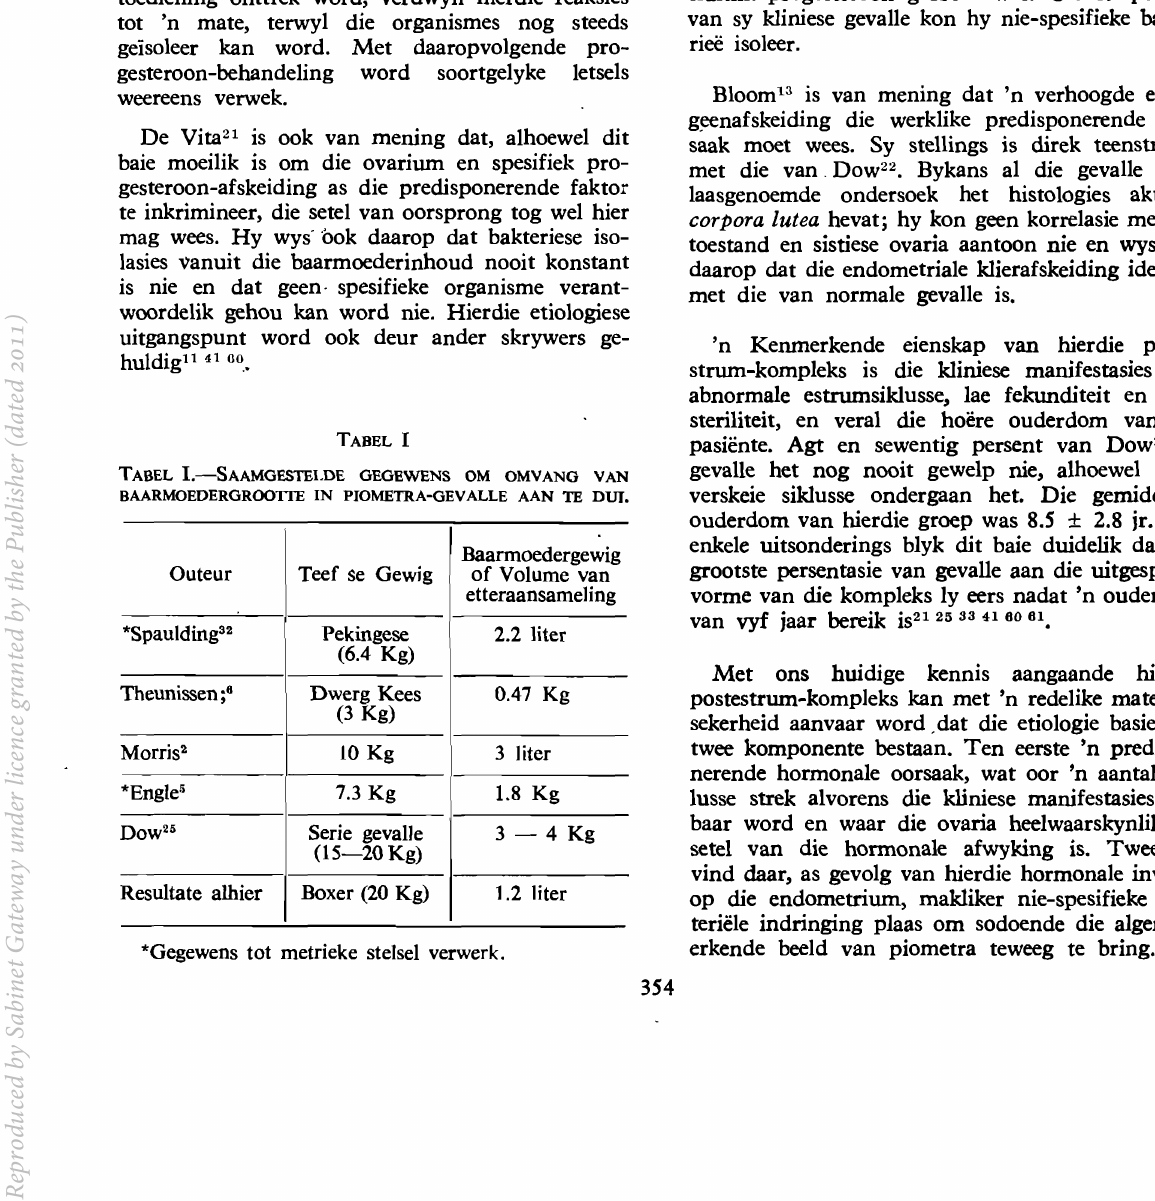
TABEL I.-SAAMOESTELDE OEOEWENS OM OMVANO VAN BAARMOEDEROROOTIE IN PIOMETRA-GEV ALLE AAN TE DUI.